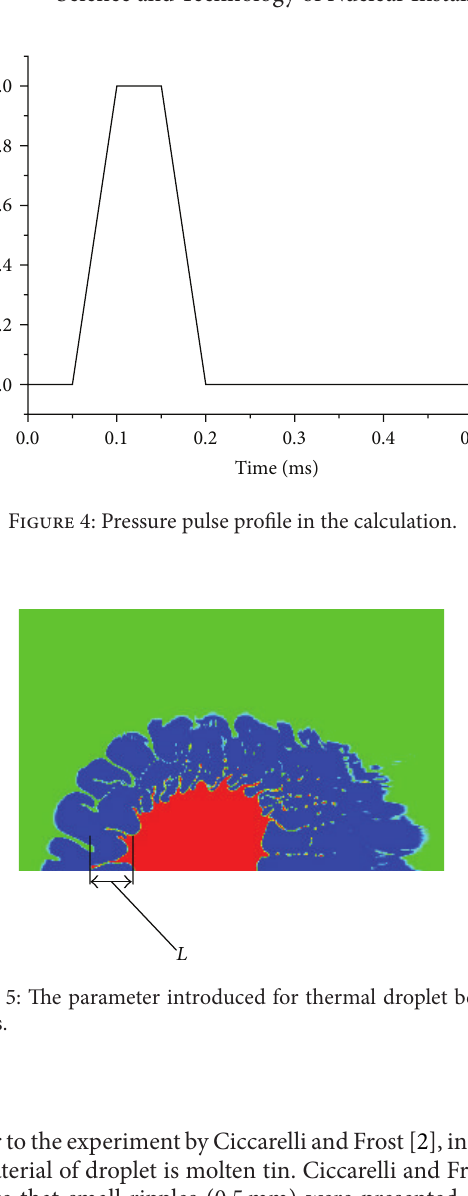
Figure 5: The parameter introduced for thermal droplet behavior